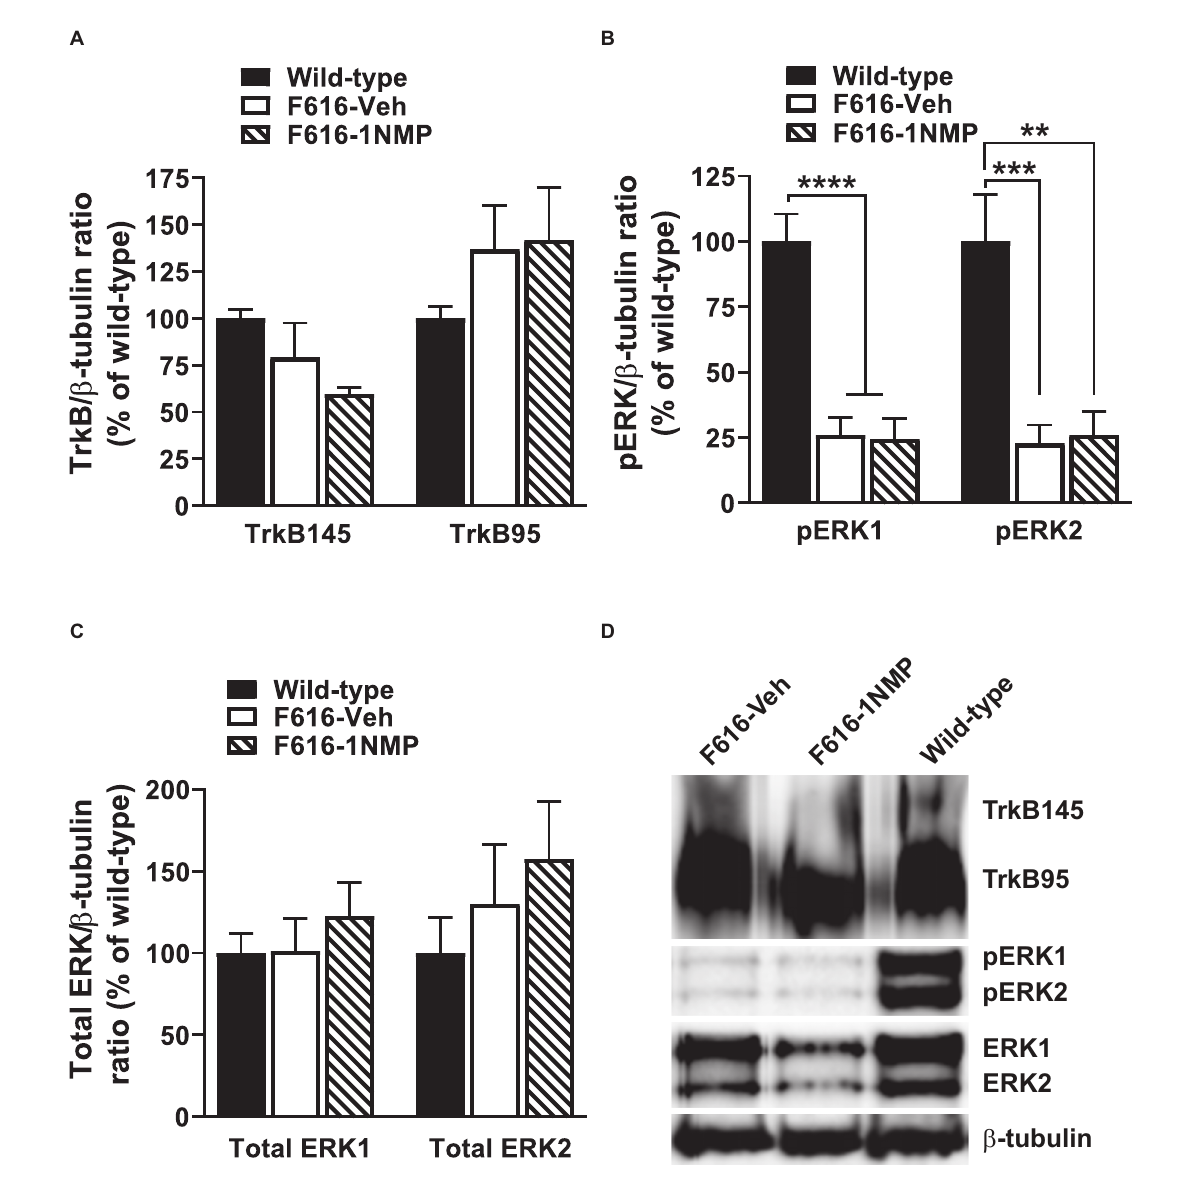
FIGURE2 Spinal expression of TrkB, pERK, and ERK in formalin inflammatory pain. (A,C) There were no differences in the spinal protein expression of TrkB and ERK isoforms, respectively, among the three groups of mice 24 h after formalin injection. (B) The levels of both pERK1 and 2 were